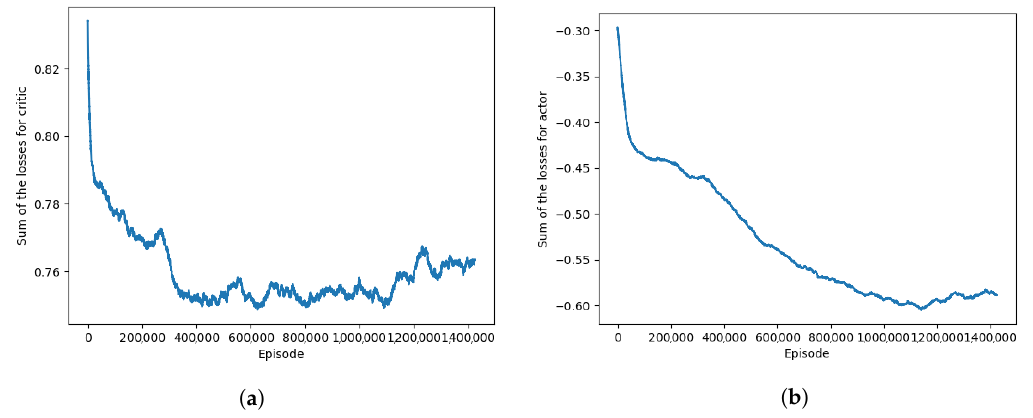
Figure 5. The loss values of ( a ) the critic learning process and ( b ) the actor learning process. While the loss values for the critic network does decrease over time, signalling to get closer to an optimum, the negative values of actor loss are only getting bigger—indicating that the actor is still far from converging to an